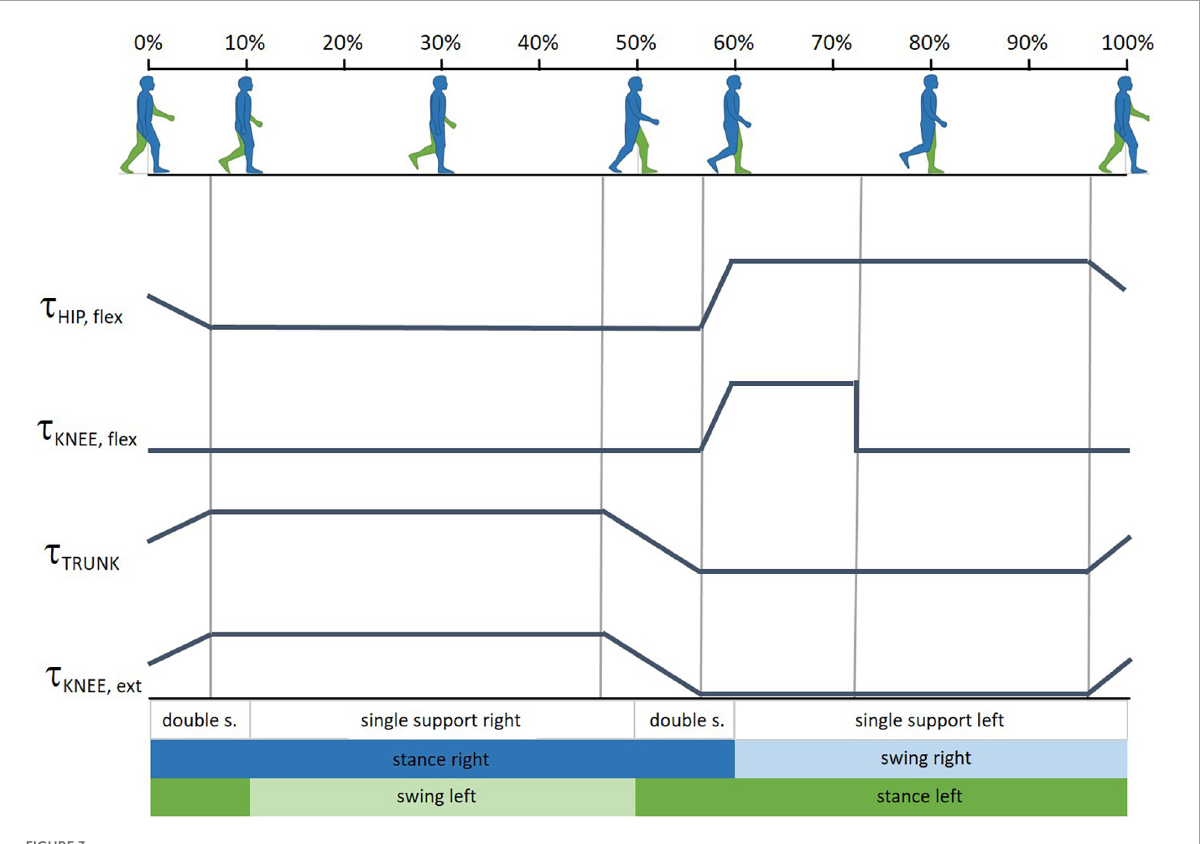
FIGURE3 Gait cycle phases and the timing profiles of the assistance provided at articular joints at T1.3. τ HIP , flex and τ KNEE , flex are the assistive torque, respectively, provided at the hip and knee joint during the toe-off phase of the impaired leg; τ TRUNK is the assistive torque provided to keep the torso erect; τ KNEE , ext is the assistive torque provided at the impaired knee during the landing phase. Gait phase graphics modified from BoH–Own work, CC BY-SA 4.0,